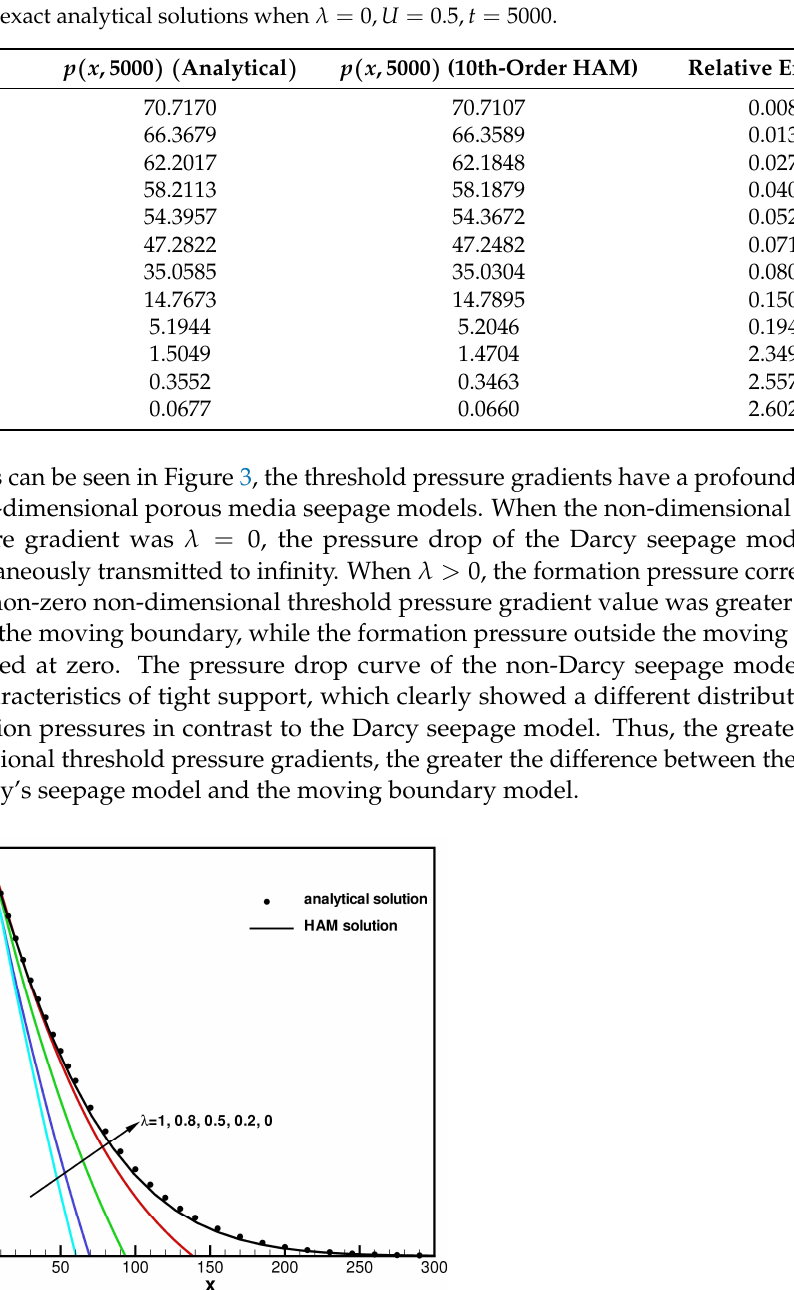
Figure 3. Comparisons between the results of dimensionless formation pressure p ( x , t ) of 10th-order HAM and the exact analytical solutions of the non-dimensional formation pressure distribution depending on λ when U = 0.5, t =